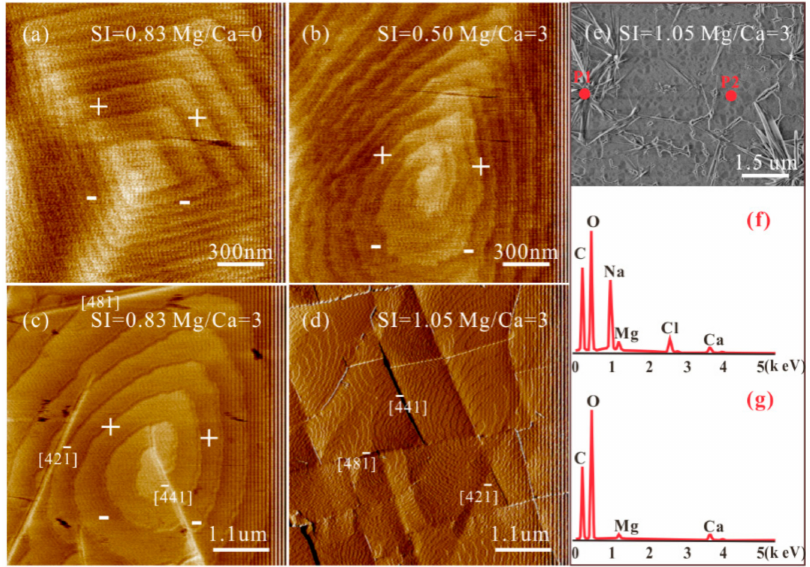
Figure 2. AFM results of the calcite (104) cleavage surfaces in solutions at pH = 8.0 ± 0.1 of height images with ( a ) SI calcite = 0.83, Mg 2 + / Ca 2 + = 0; ( b ) SI calcite = 0.50, Mg 2 + / Ca 2 + = 3; ( c ) SI calcite = 0.83, Mg 2 + / Ca 2 + = 3; and deflection image with ( d ) SI calcite = 1.05, Mg 2 + / Ca 2 + = 3; and ( e ) SEM image with SI calcite = 1.05 and Mg 2 + / Ca 2 + = 3 , and ( f ) and ( g ) represent EDS analysis of P1 and P2 labeled in ( e ),